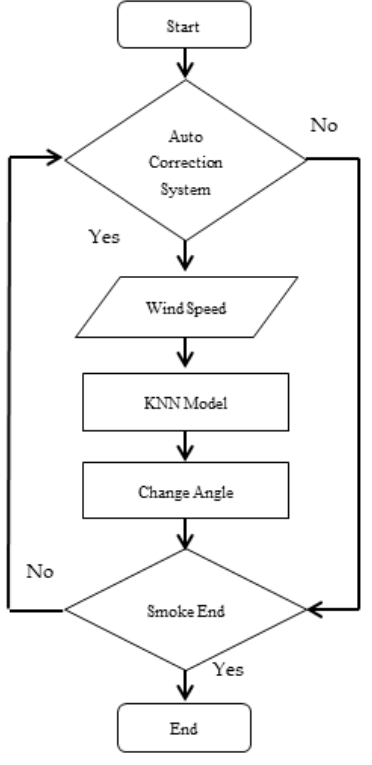
Figure 7. Autocorrection flow chart for smoke trailing.